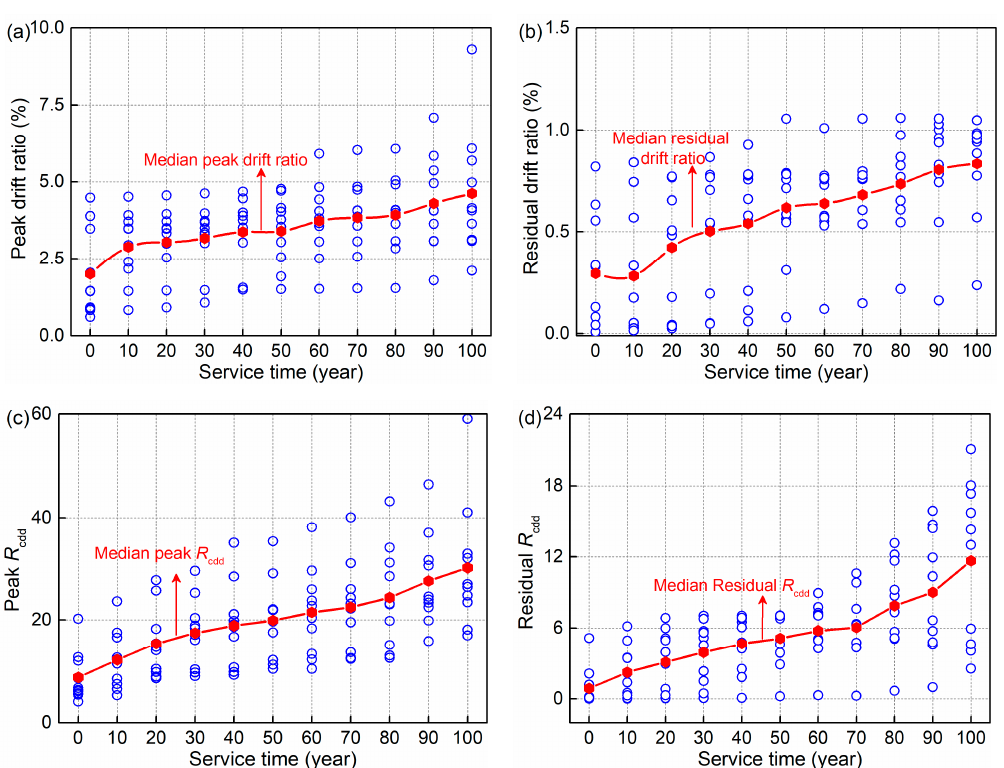
Figure 18. Distribution of HRC bridge column response over time: ( a ) peak drift ratio; ( b ) residual drift ratio; ( c ) peak R cdd ; ( d ) residual R cdd .